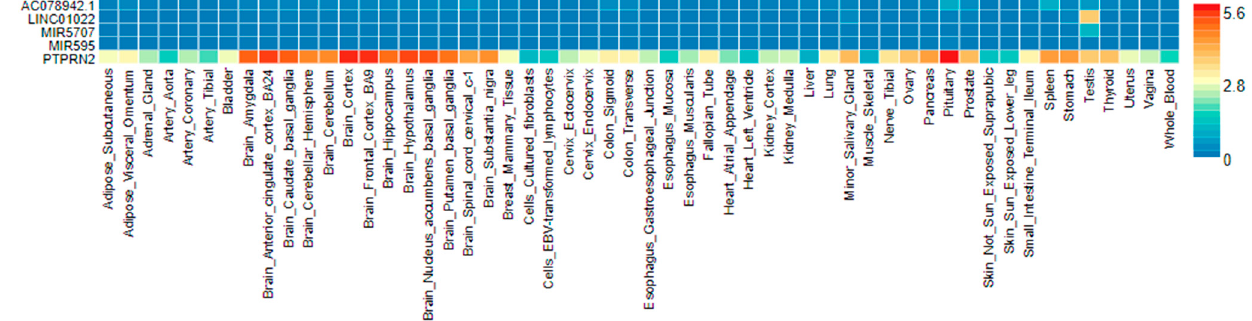
Figure 4. Gene expression heat map based on the data set GTE × V8 (54 tissue types), showing the average expression per label for the expression of the PTPRN2 gene and the regional overlapping genes MIR5707, MIR595, AC078942.1 and LINC01022.